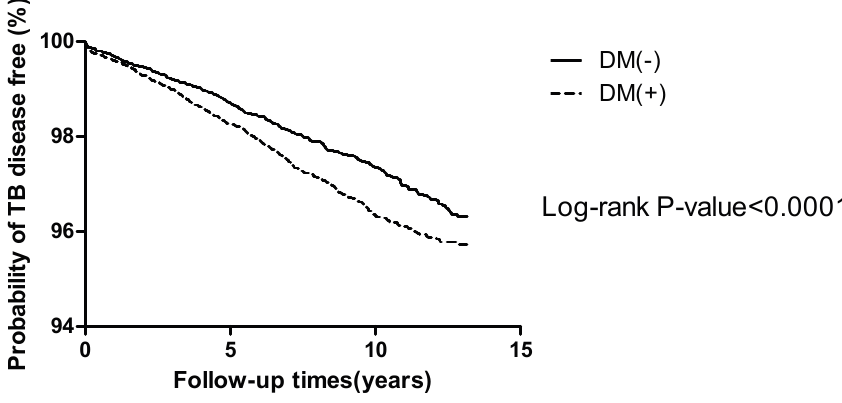
Figure 2. Kaplan–Meier curve for the patients with and without diabetes for the time to tuberculosis infection. DM = diabetes mellitus; TB = tuberculosis.